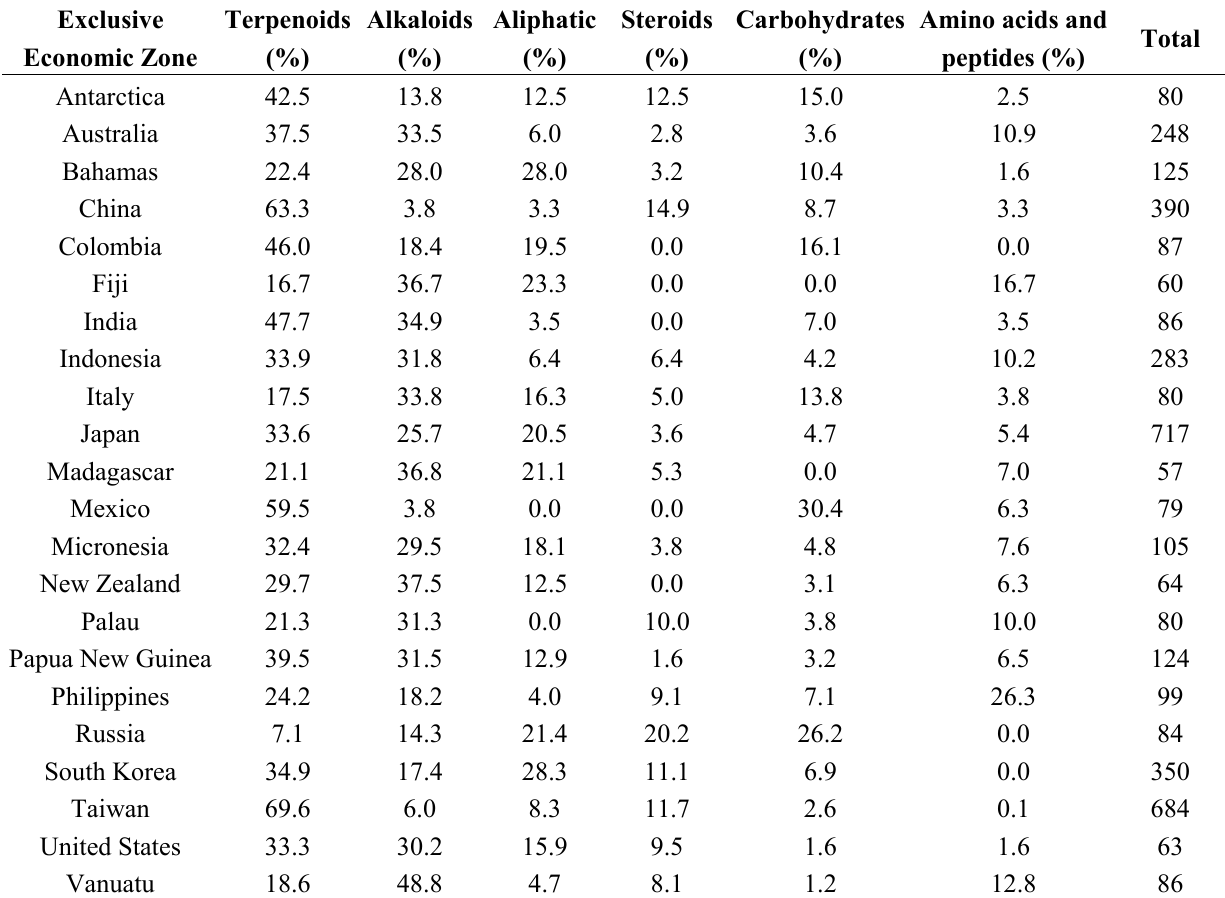
Table 3. Percentage of new marine natural products (NPs) from invertebrates from different chemical groups reported from different Economic Exclusive Zones (EEZs). The total number of new NPs from marine invertebrates discovered in each EEZ is also